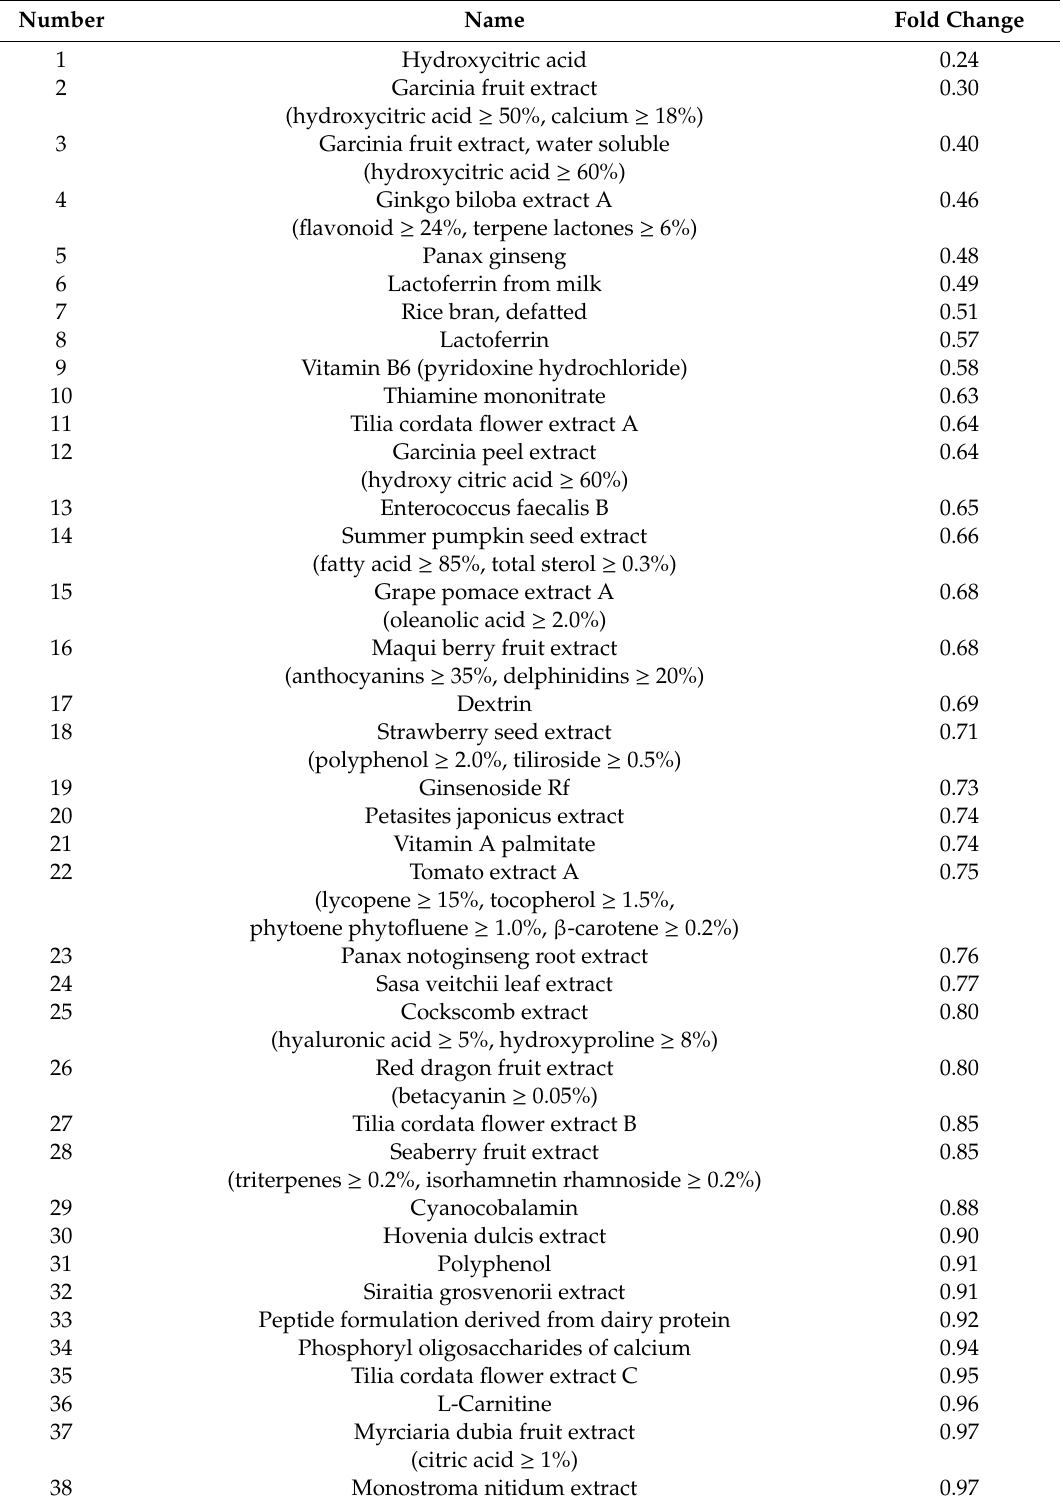
Table A1. First screening of HIF